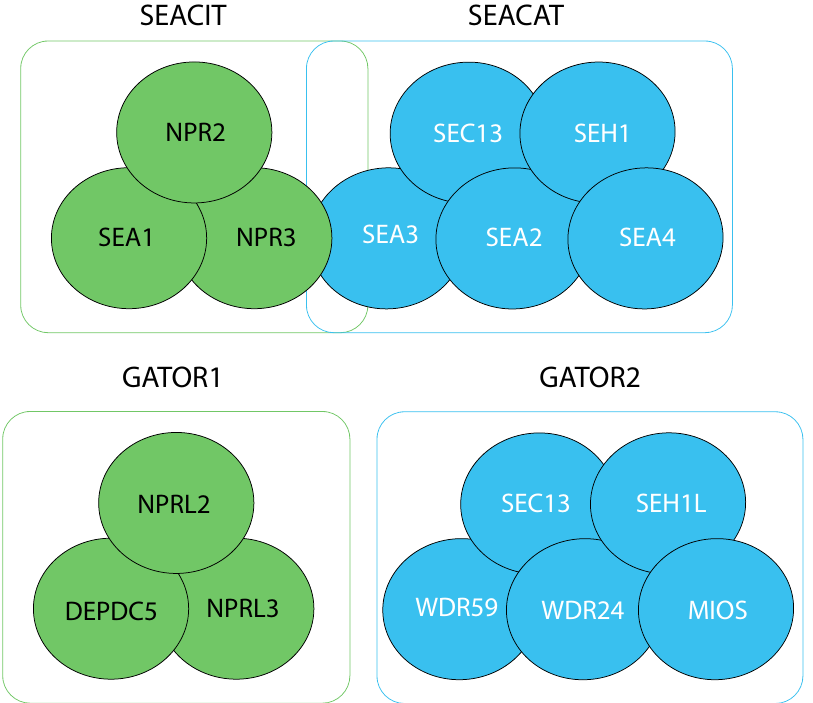
Figure 1. Composition of yeast SEA complex and mammalian GATOR complex. SEACIT subcomplex in yeast can tightly interact with SEACAT, most probably via Npr3/Sea3 connection. GATOR1 and GATOR2 do not form a stable full GATOR